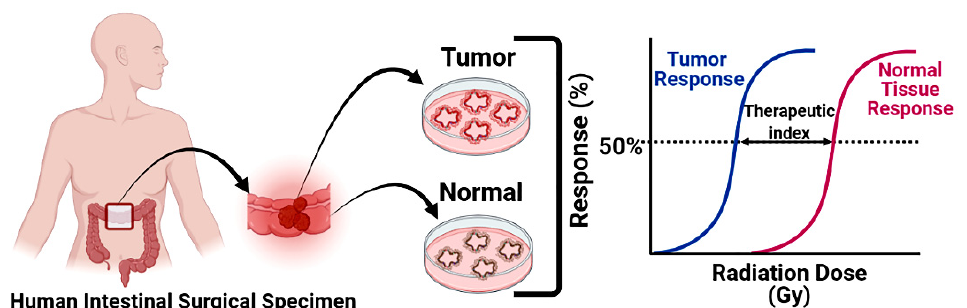
Figure 5. Paired organoid system (POS) to determine radiation response to both normal and malignant tissue collected from same organ. POS can determine therapeutic index of radiation in ex vivo in a personalized basis.